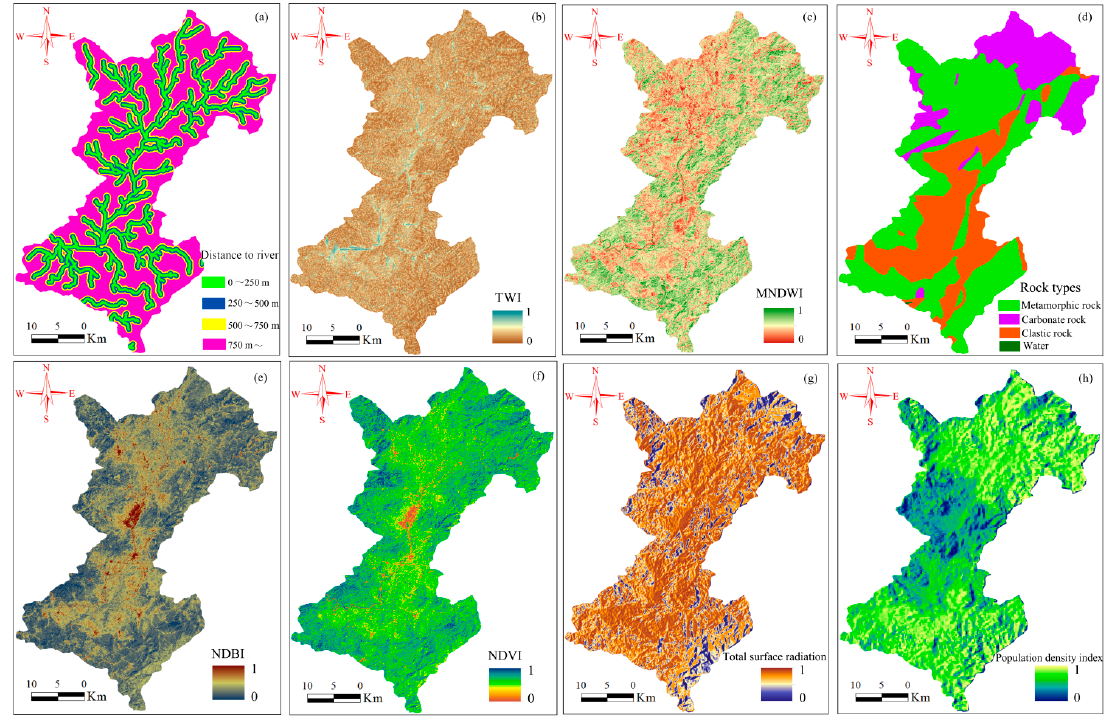
Figure 3. Hydrological, lithological, and land cover factors in Shicheng County, ( a ) Distance to river, ( b ) TWI, ( c ) MNDWI, ( d ) Rock types, ( e ) NDBI, ( f ) NDVI, ( g ) Total surface radiation, ( h ) Population density index.